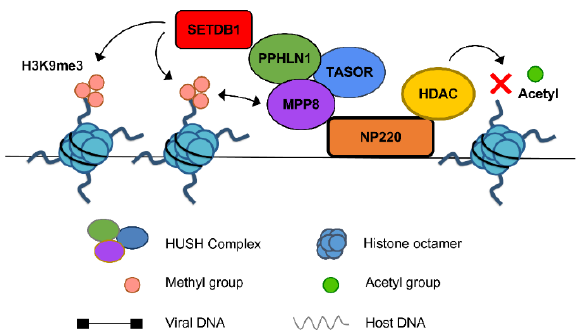
Figure 1. Silencing complex bound to unintegrated MLV DNA. The various proteins implicated in silencing incoming unintegrated DNA of the Moloney murine leukemia virus are depicted here. NP220 is bound directly to specific sequence elements on the viral DNA, and acts as a tether to bring histone deacetylases (HDACs) to remove acetyl groups from nearby histone tails, and to bring the trimeric HUSH complex through interactions with the MPP8 subunit. This in turn brings the SETDB1 histone methyltransferase to add the H3K9me3 mark to the H3 histone tails. MPP8 further binds the complex to the DNA by its interaction with the H3K9me3 mark. From [62].